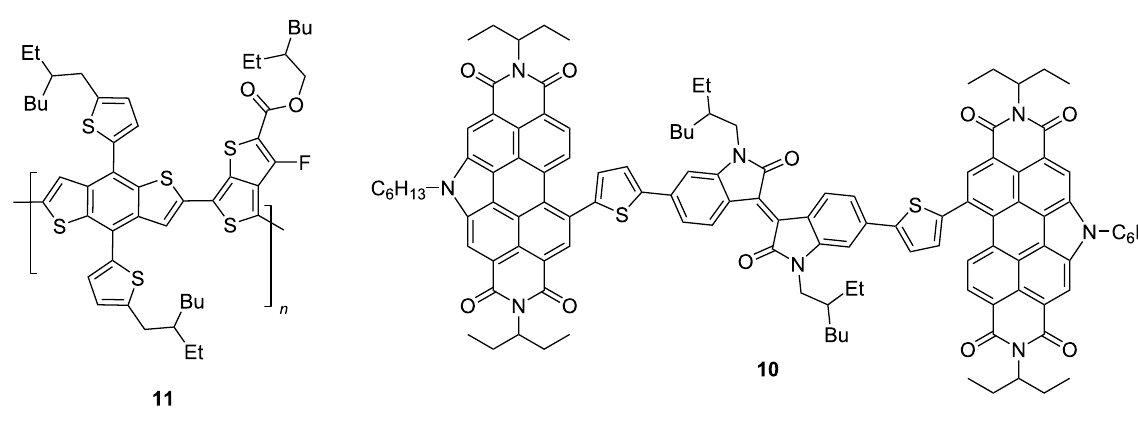
Scheme 8: Nonfullerene OSC based on perylene diimide-derived isoindigo.